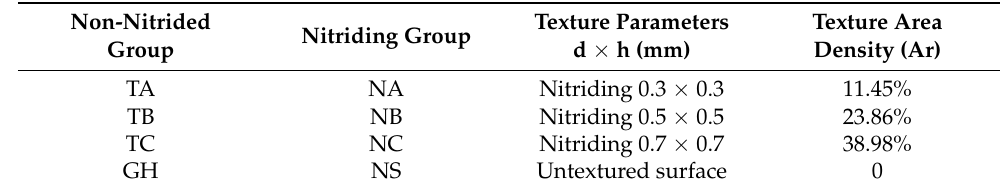
Table 2. Experimental group number.